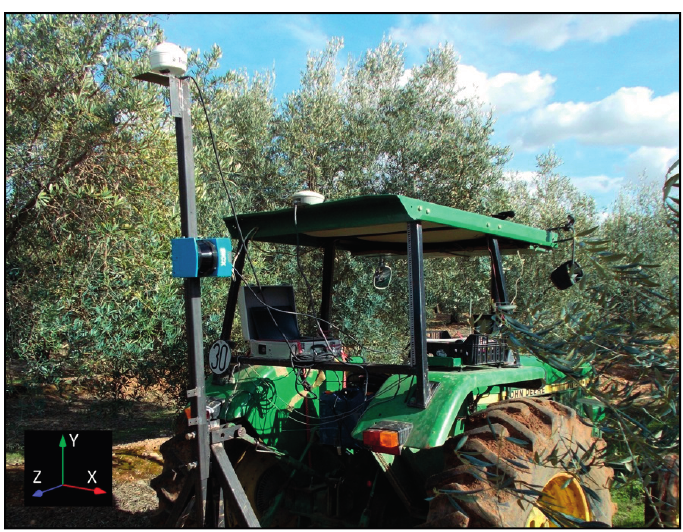
Figure 5. LiDAR sensor and laptop computer in the field, installed on the tractor.